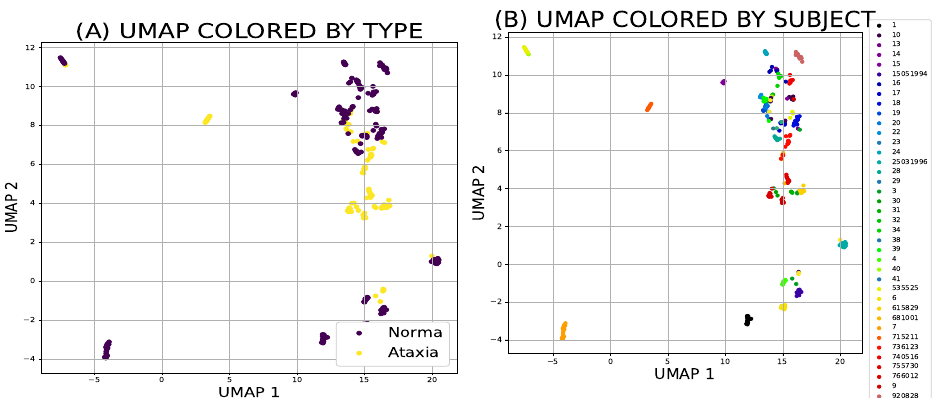
Figure 3. The uniform manifold approximation and projection model can be used for predicting a new sample to group ( A ) or similarity to the other study participant ( B